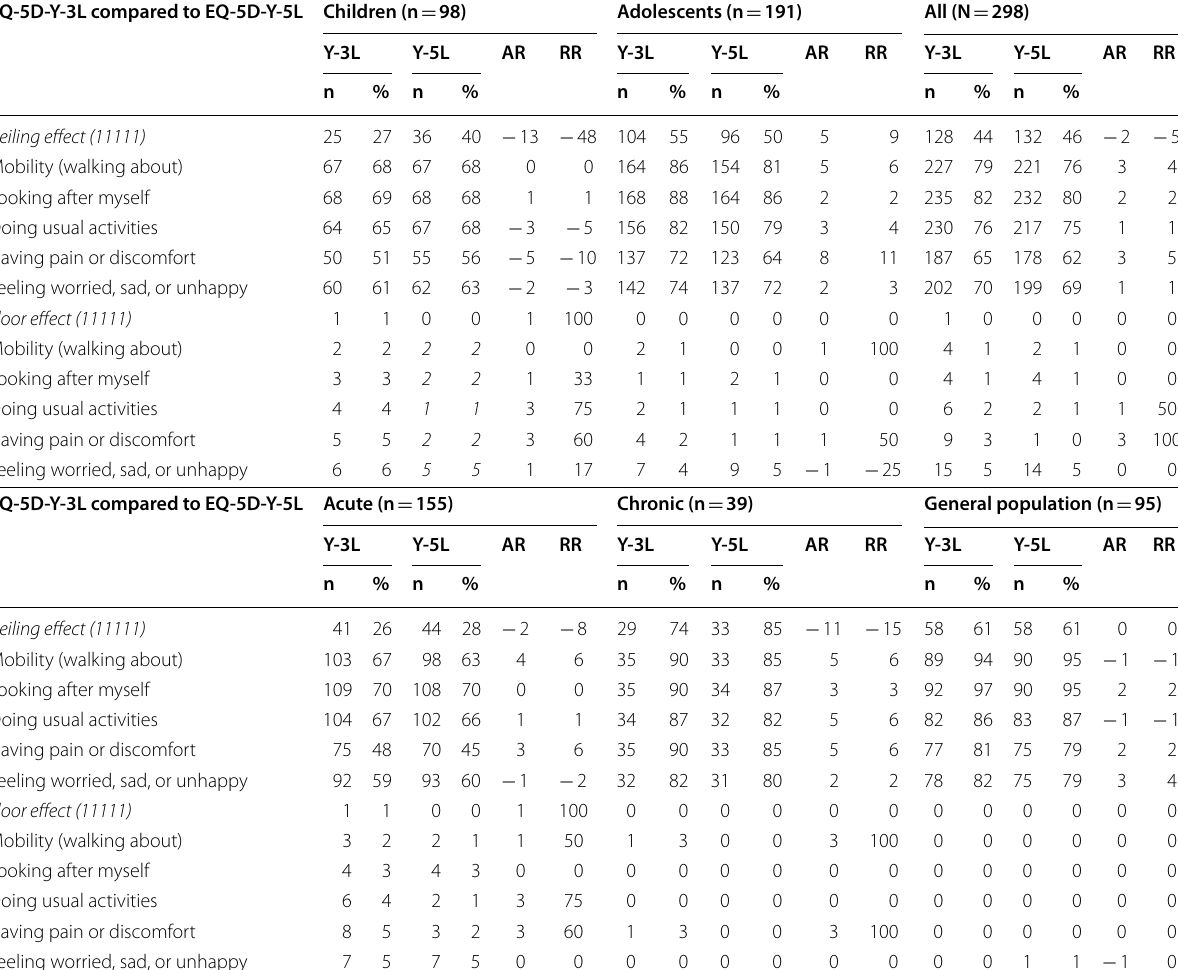
Table 3 Ceiling effect for the EQ-5D-Y-3L and EQ-5D-Y-5L across age groups and health condition